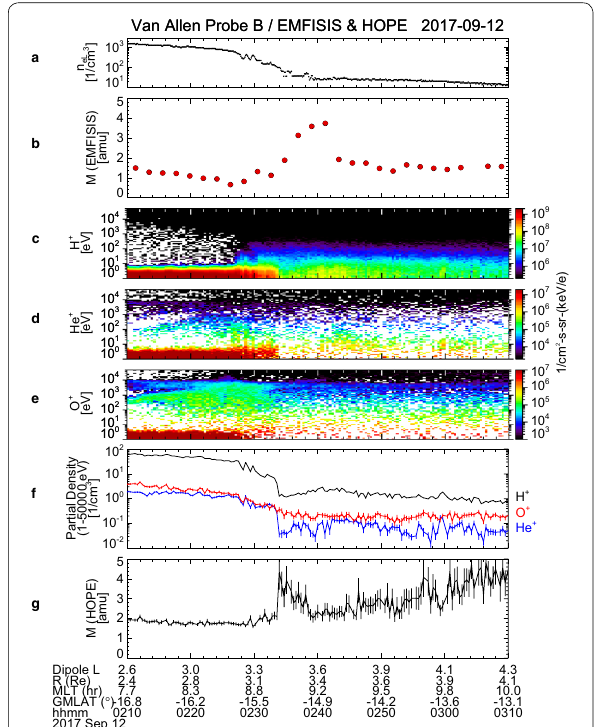
Fig. 9 Van Allen Probe B/EMFISIS observations of a electron density at the satellite position and b average plasma mass for 02:10–03:10 UT on 12 September 2017, which are the identical to Fig. 6a and b. Van Allen Probe B/HOPE observations of c – e the energy-time diagrams of H + , He + , and O + ions, f partial densities of H + (black), He + (blue), and O + (red) ions calculated from ion fluxes over the energy range of 1 eV–50 keV, and g average plasma mass calculate from the partial densities, for 02:10–03:10